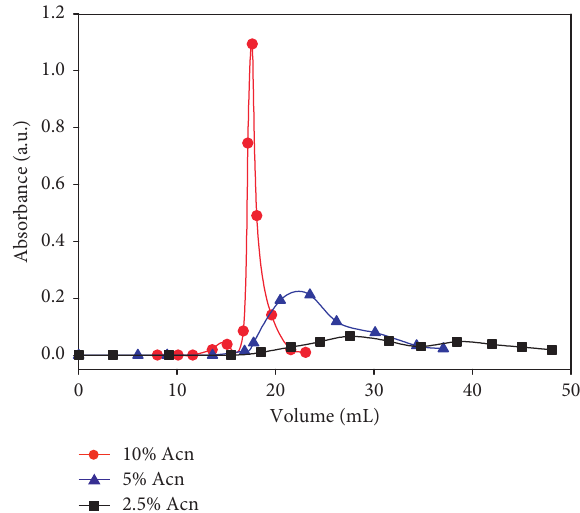
Figure 3: SY profiles obtained with step gradient elution. Eluent: 2 mmol · L − 1 KH 2 PO 4 (pH 3) containing 2.5% acetonitrile with step increase to 5% or 10% after 10 mL. SY amount is 75 μ g.